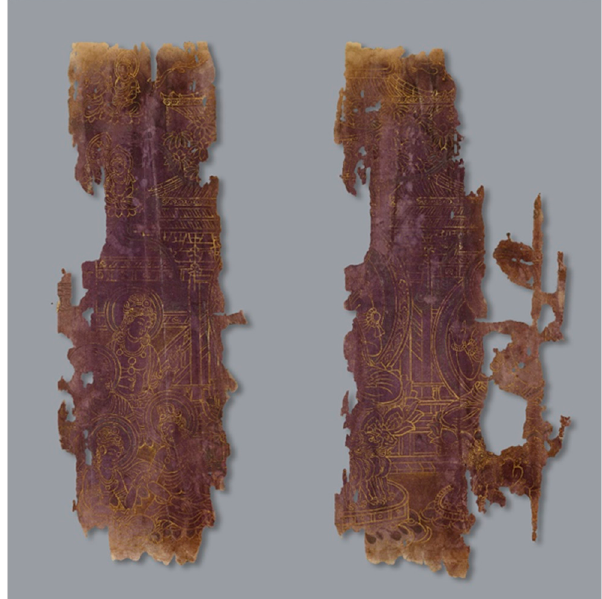
Figure 6. Frontispiece to the Flower Garland S ū tra . Ca. 754–755 CE, Silla (57 BCE–935). Gold and silver pigment on red mulberry paper. H. 25.7 cm; L. 10.9 cm; H. 24.0 cm; L. 9.3 cm. Leeum, Samsung Museum of Art.